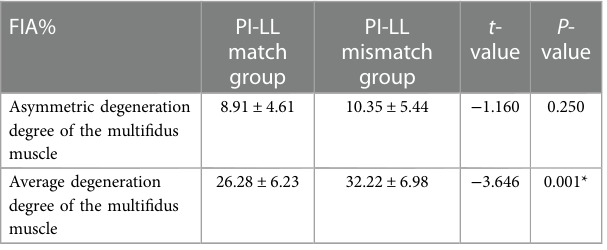
TABLE 4 Asymmetric and average degeneration degree of the multi fi dus muscle between PI-LL match and PI-LL mismatch groups.